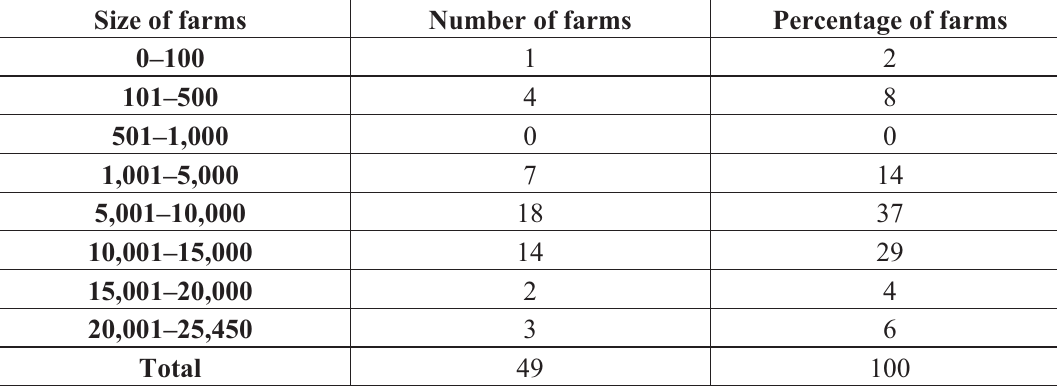
Table 2. Distribution of farm sizes.